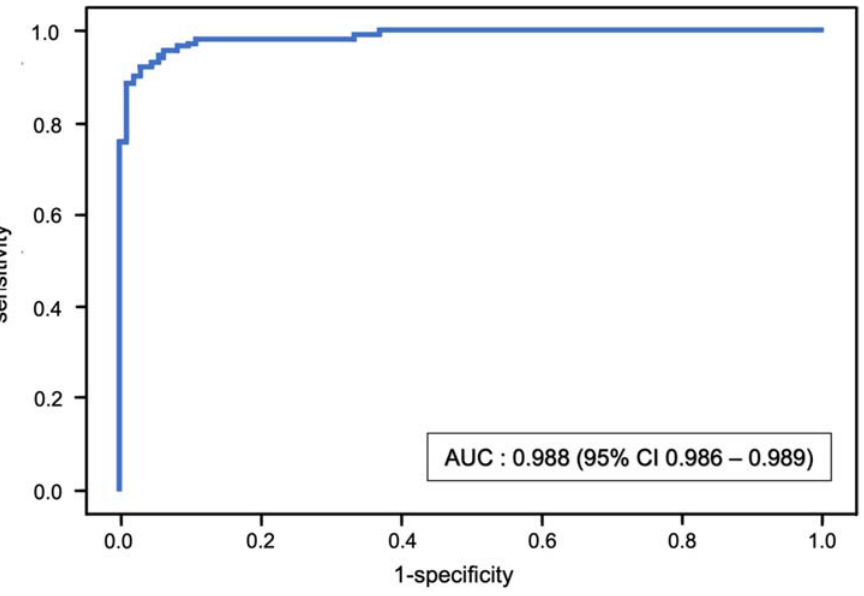
Figure 4. Receiver operating characteristic (ROC) curve and mean area under the curve (AUC) for the binary classification of sarcopenia using the XGBoost model.